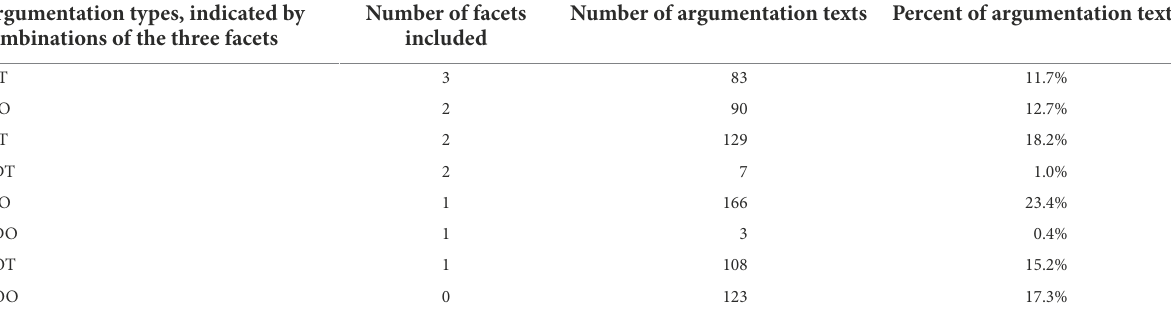
TABLE 2 Prevalence of the argumentation types, indicated by combinations of the facets Justification (J), Disconfirmation (D), and Transparency (T), in the 709 argumentation texts. Argumentation types, indicated by combinations of the three